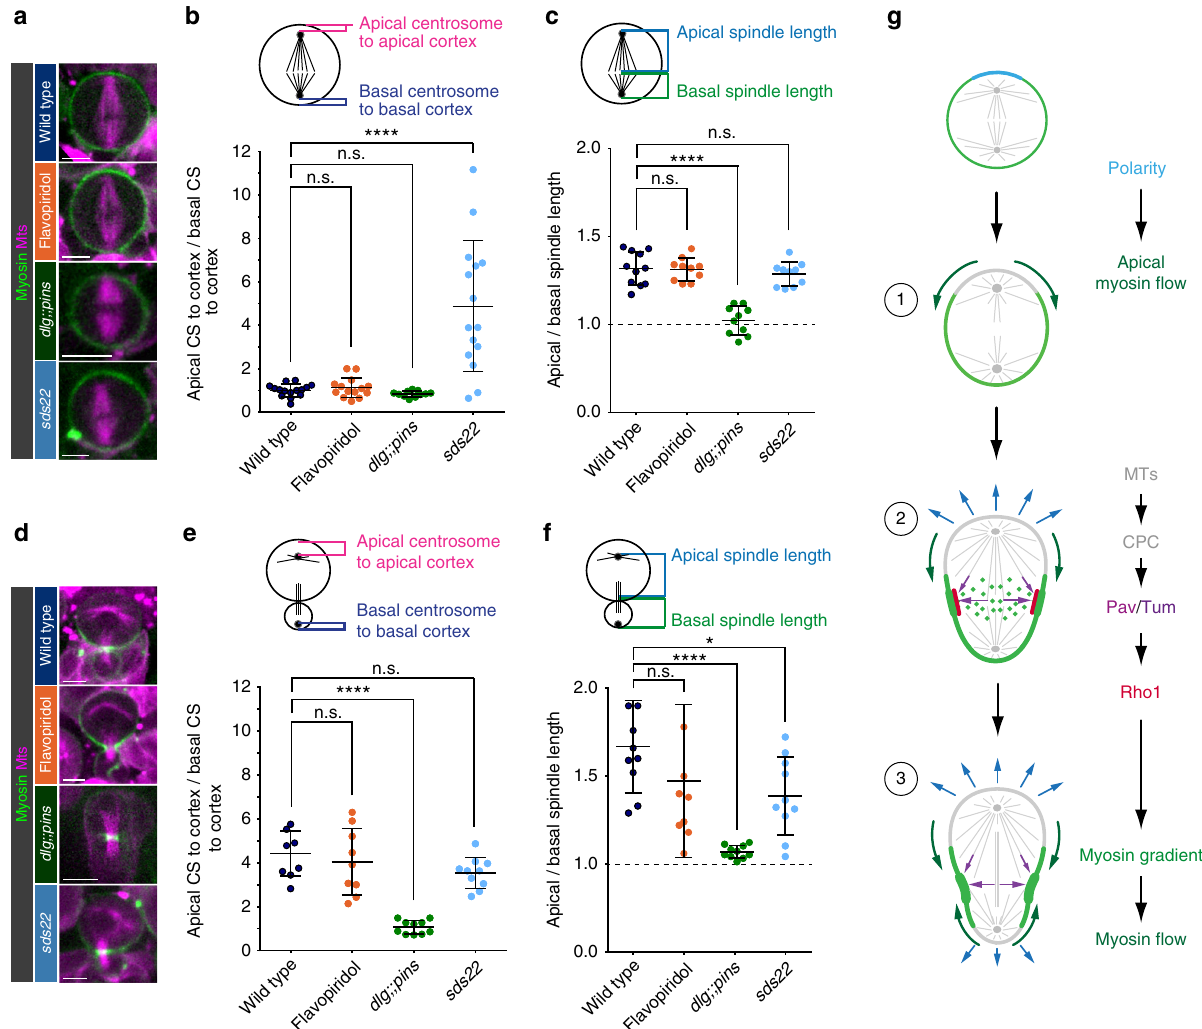
Fig. 8 Spindle asymmetry and positioning contribute to cleavage furrow placement and physical asymmetry. Representative snapshots for wild type, Flavopiridol-treated, dlg;;pins and sds22 mutant ( a ) metaphase and ( d ) telophase neuroblasts. Myosin is shown in green and MTs in magenta. b , e Scatter plots showing spindle position and ( c , f ) spindle asymmetry for each genotype at metaphase and telophase, respectively. g Model. In Drosophila neuroblasts, polarity cues are used to initiate an apical — basal Myosin fl ow. Apical clearing of Myosin allows apical cortical expansion. Subsequently, Myosin fl ows from the basal towards the apical neuroblast cortex induced through a lateral Myosin gradient, which is established through anaphase spindle cues. The chromosomal passenger and centralspindlin complexes are required to enrich for Myosin on the lateral cortex, initiating basal Myosin clearing. Spindle positioning and geometry are key factors to localize the site of cleavage furrow formation, con fi ning Myosin enrichment to the lateral cortex. See text for details. Center values and error bars represent the mean and standard deviation (s.d), respectively. Asterisks denote statistical signi fi cance, derived from unpaired t tests: * p ≤ 0.05, ** p ≤ 0.01, *** p ≤ 0.001, **** P ≤ 0.0001. Each measured cell (n) is represented with a dot in the scatter plots. For each experiment, the data were collected from at least 3 independent experiments. For each independent experiment, at least 5 larvae were dissected. Scale bars: 5 µ m. n.s. not signi fi cant